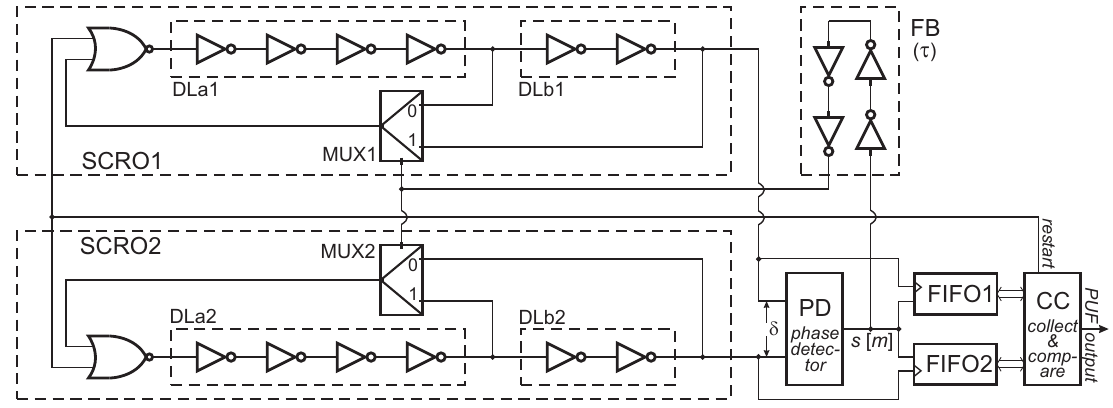
Figure 1. The block diagram of the proposed chaos-based PUF